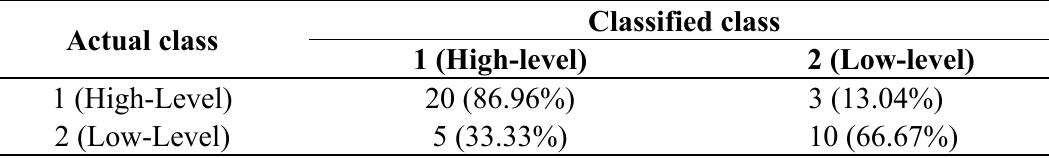
Table 7. RST-SVM model (model IV) results with only significant variables.